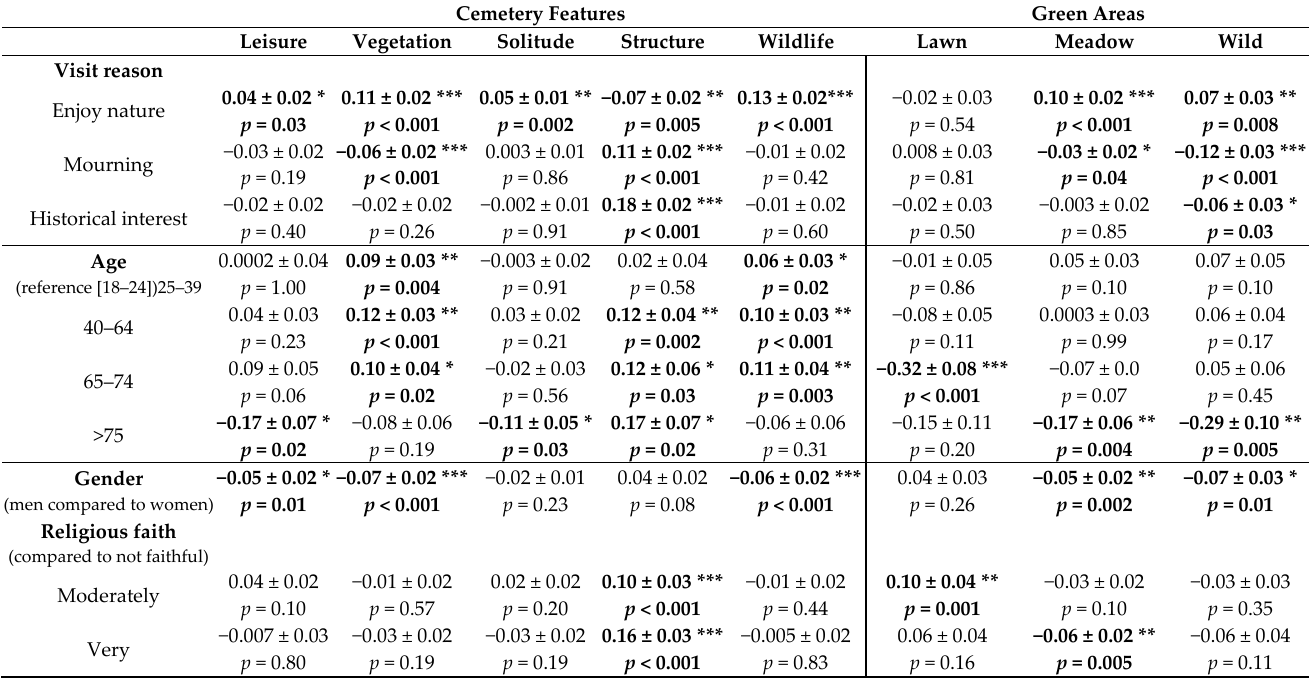
Table 2. The predictive potential of different reasons of cemetery visits and of the respondents’ sociodemographic factors on preferences for cemetery features and for differently managed green areas. Significant results shown in bold with p -values (* p < 0.05; ** p < 0.01; *** p < 0.001).